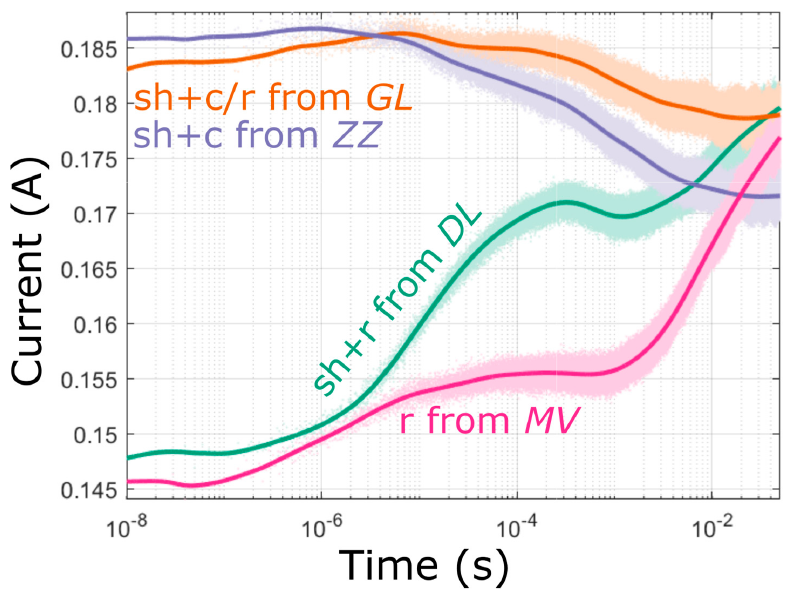
Figure 8. Time-domain current transients from ZZ , GL , DL to MI points for device D at T c = 40 ◦ C. Lighter shades of color identify acquired points, while solid lines are smoothed versions of the current